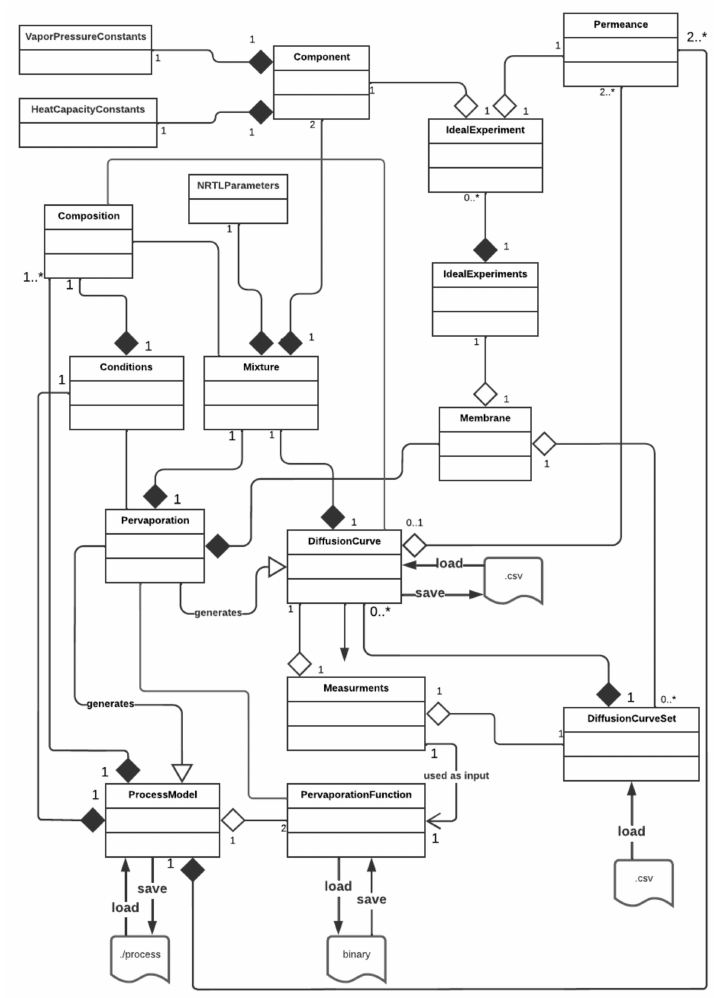
Figure 3. A schematical representation of PyVaporation’s